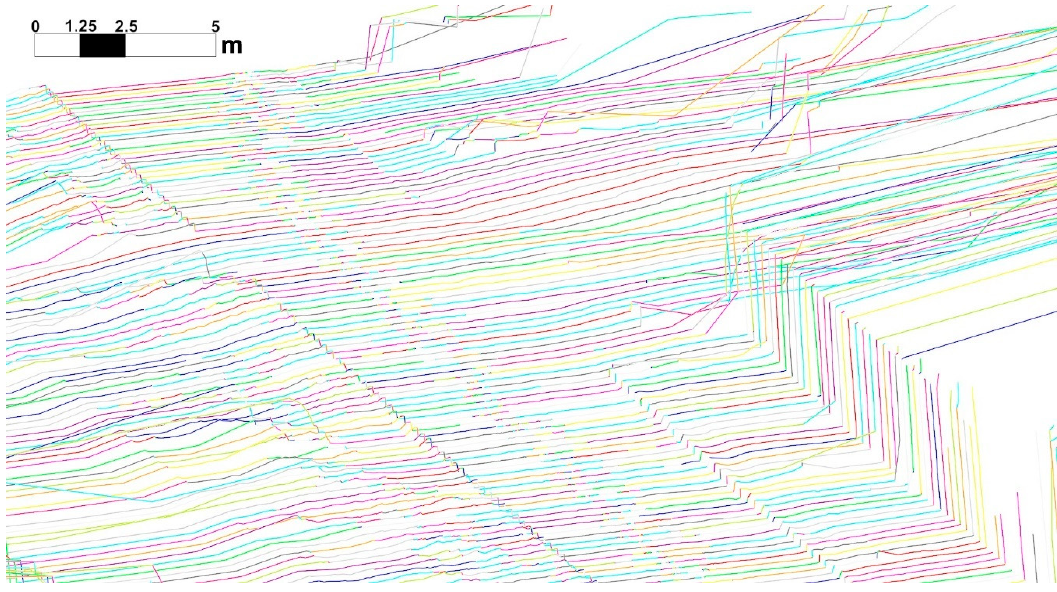
Figure 11. Colored TCS’s monotone decomposition